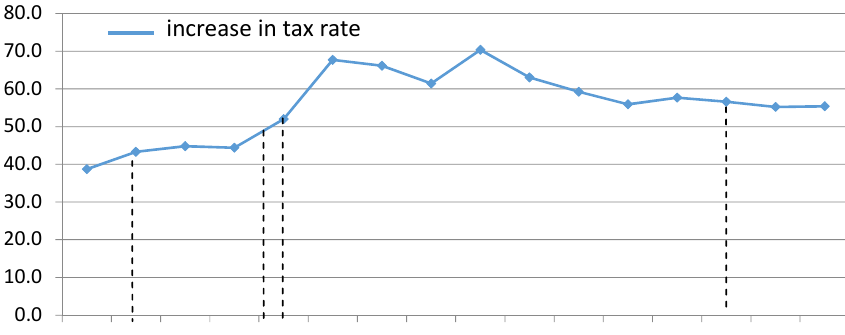
Figure 2. Development of the contribution to the state budget from the tax on beer in the years 1999 to 2014 in € millions. Source: own calculations based on data from the Financial Directorate of the Slovak